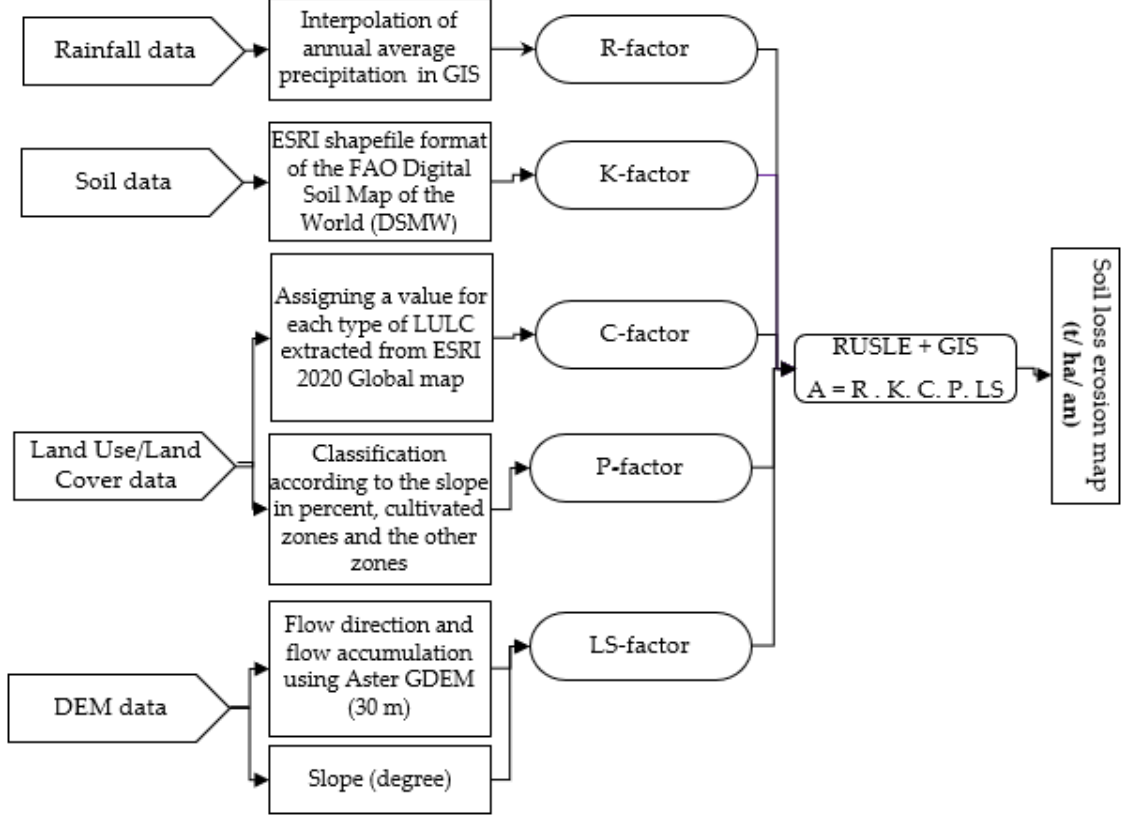
Figure 4. Flow chart for the analysis of soil loss based on the RUSLE model and GIS technique.